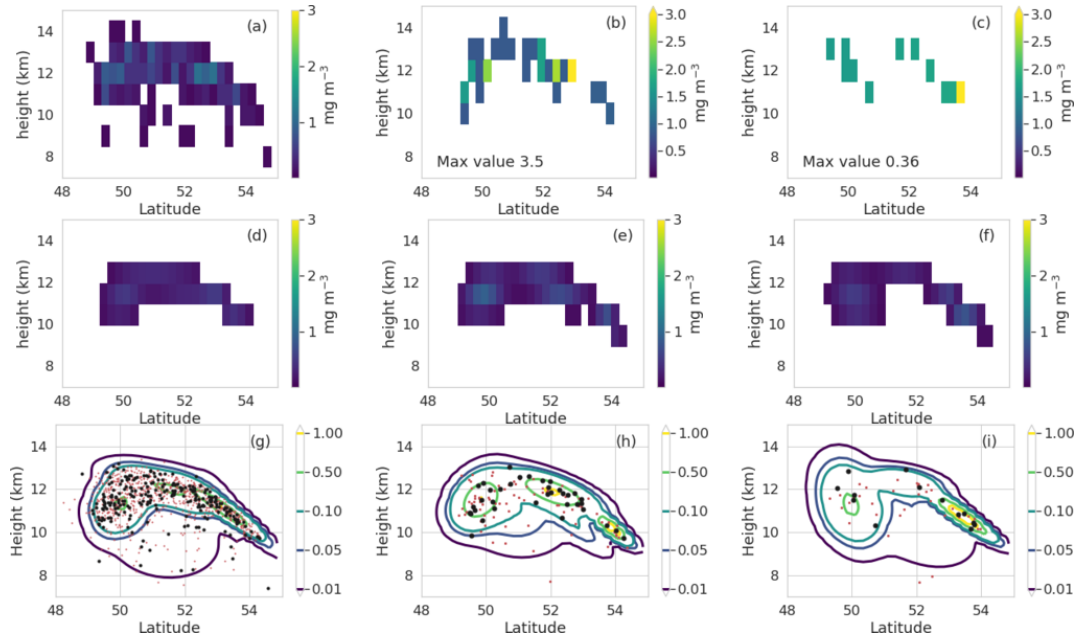
Figure 6. Concentrations at longitude − 145. Top row ( a – c ) concentrations calculated using histogram method. Second row ( d – f ) and third ( g – i ) row concentrations calculated using GMM with 50 Gaussians and plotted at the same resolution as the histogram method in the second row and the contours in the third row are for with a higher vertical resolution (0.25 ◦ × 0.25 ◦ × 100 m). First column ( a , d , g ) Run KA, second column ( b , e , h ) Run KB and third column ( c , f , i ) run KD. The black dots in the third row indicate position of particles within 0.125 ◦ of the − 145 line of longitude. The red dots indicate position of particles within 0.5 ◦ of the − 145 line of